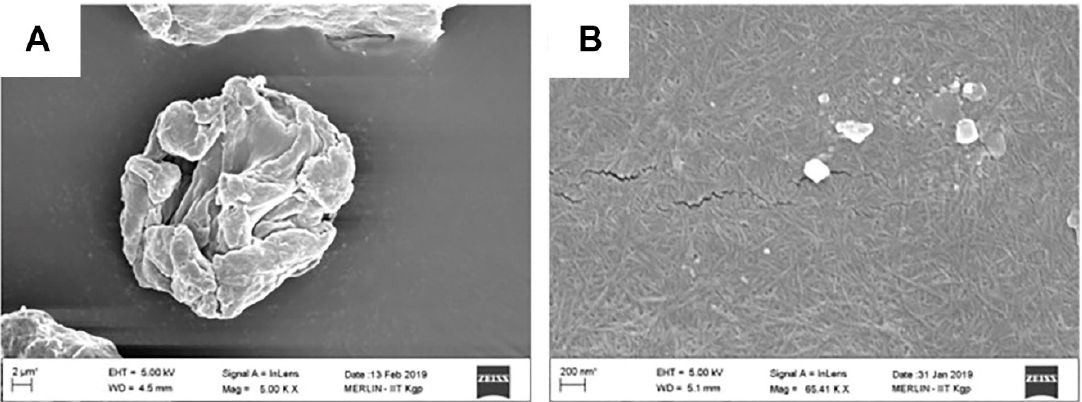
Figure 5. SEM images of CNCs morphologies from ( A ) freeze-drying method and ( B ) drop-casting method (Reprinted with permission from ref [43]. Copyright © 2020 Elsevier) .